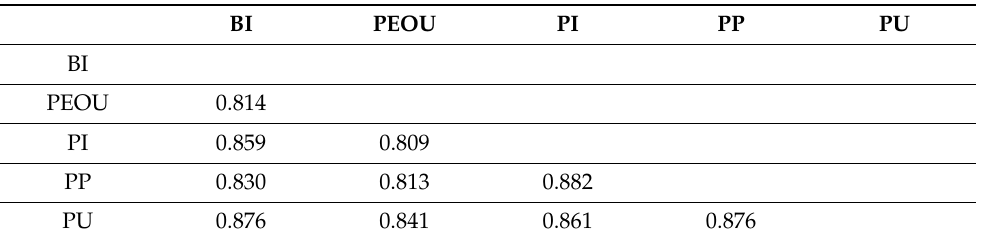
Table 6. HTMT results.